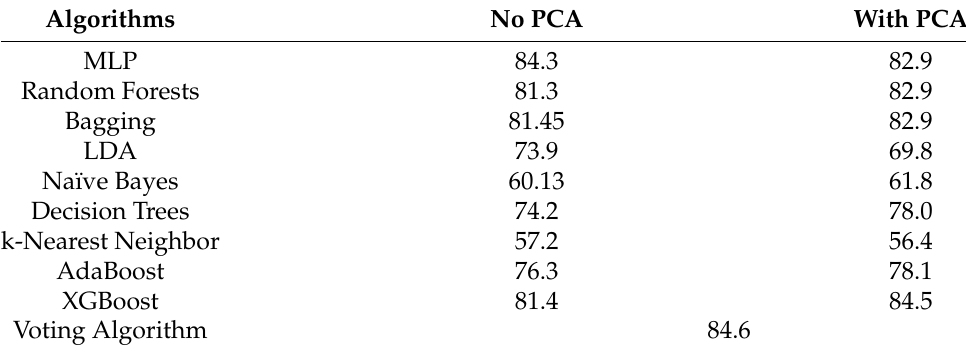
Table 3. F1-Score (Macro) results (in percentage) of the training, for each ML algorithm without PCA and the use of PCA for variable